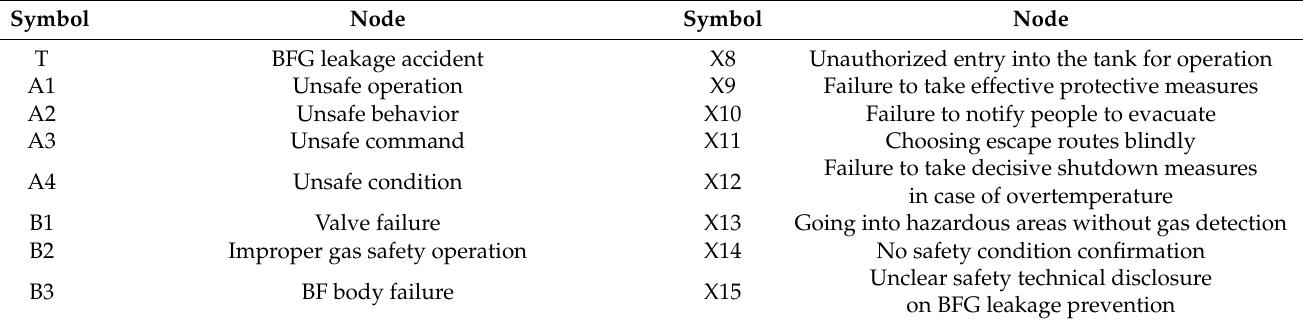
Table 2. Names and symbols of nodes in BN of BFG leakage